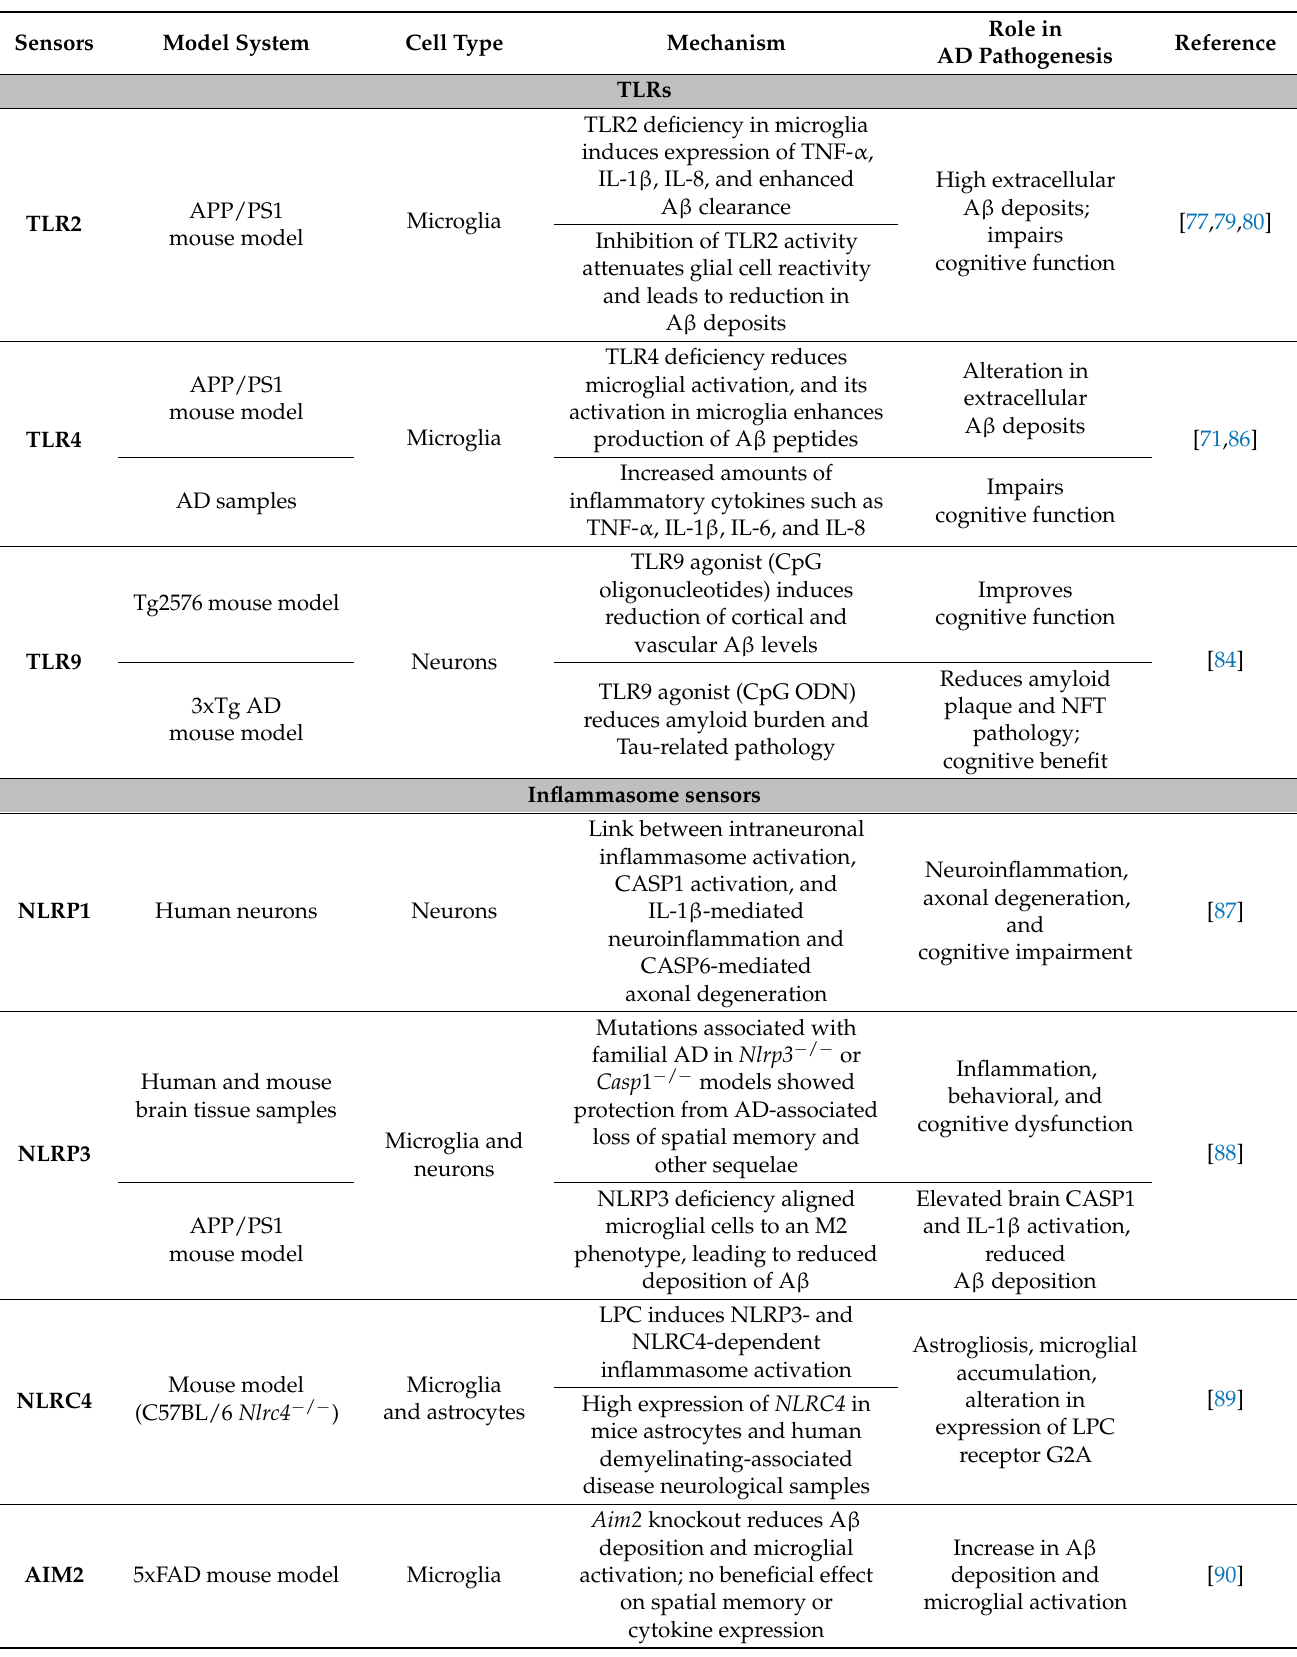
Table 2. Innate immune molecules involved in Alzheimer’s